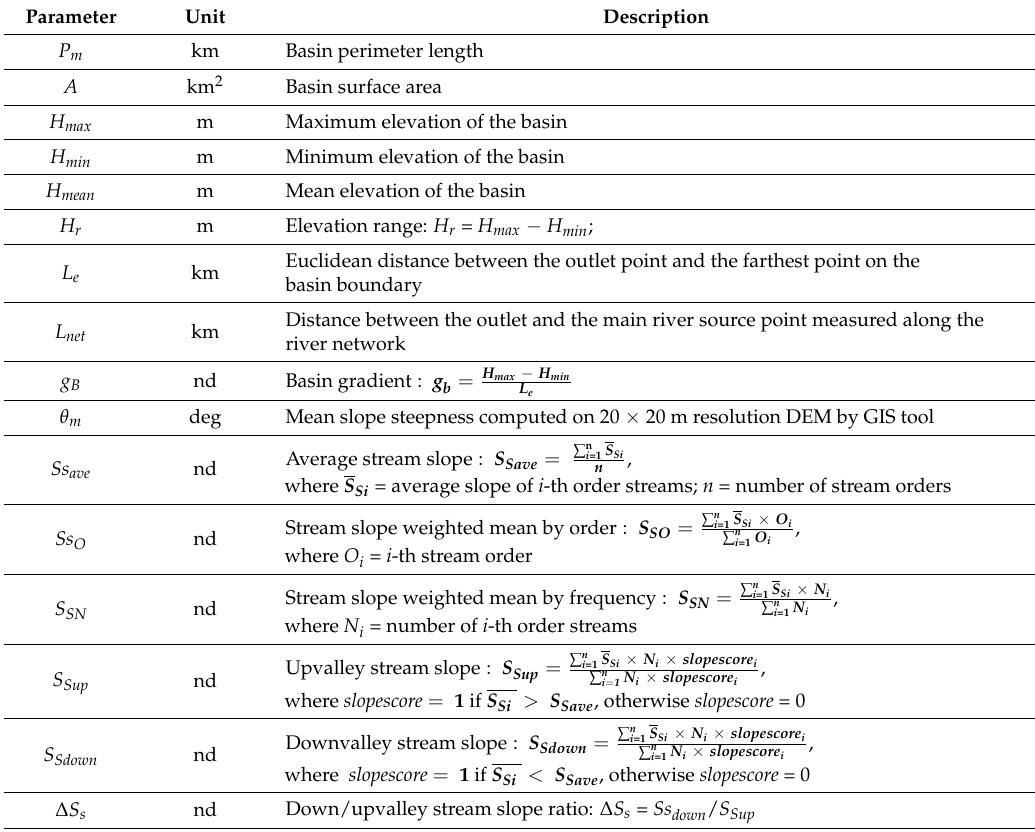
Table A1. Parameters describing the catchment plano-altimetric features.